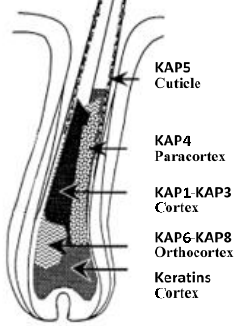
Figure 3. Schematic representation of the sites of KAP gene expression in the wool follicle. Modified from Powell and Rogers [5].